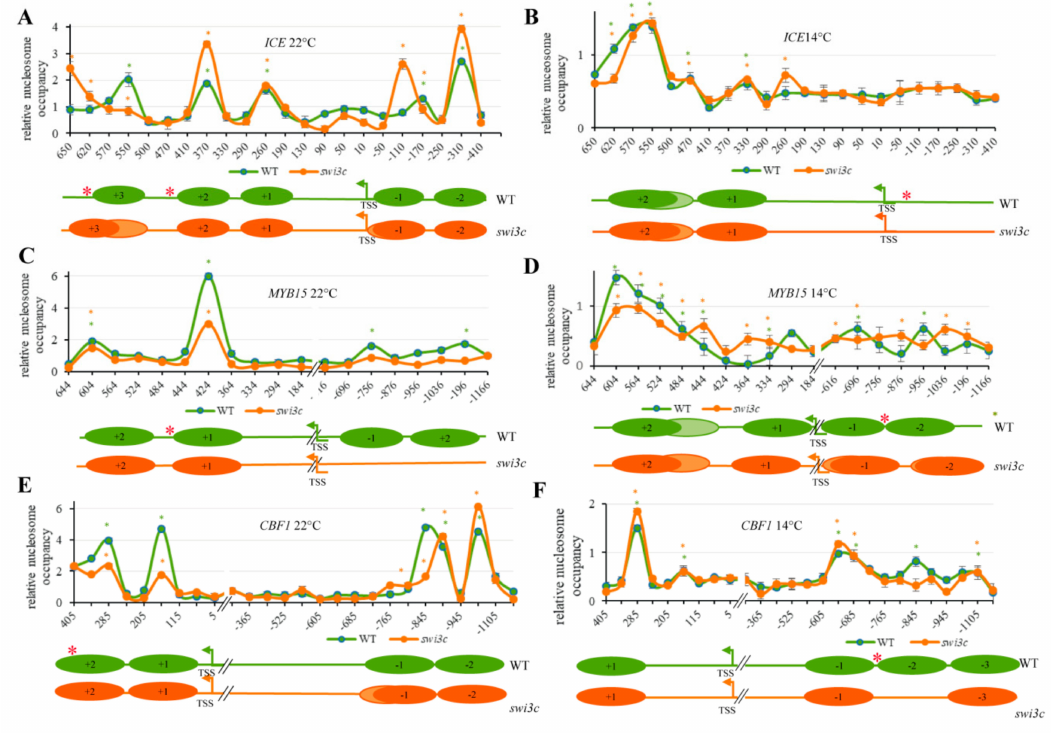
Figure 3. The E ff ect of SWI3C Inactivation on Nucleosomal Structures of ICE1 , MYB15 and CBF1 Genes. ( A ) Relative nucleosomes occupancy on the ICE1 locus in WT and swi3c plants grown at 22 ◦ C and ( B ) 14 ◦ C. ( C ) Relative nucleosome occupancy on MYB15 in WT and swi3c plants at 22 ◦ C and ( D ) 14 ◦ C. ( E ) Relative nucleosome occupancy on CBF1 in WT and swi3c plants at 22 ◦ C and ( F ) 14 ◦ C. Plants were in the principal stage with 12 rosette leaves > 1mm length according to Boyes et al. (2001) [24]. Three biological and three technical replicates were used. The fraction of undigested genomic DNA amplified for each amplicon was normalized to that of the − 73 position of GYPSY-LIKE retrotransposon (At4g07700) as control. Lower panels in each figure section show schematic illustration of nucleosome positioning and dynamics. Red asterisks indicate the localization of SWI3C protein determined by ChIP-qPCR analysis. Dark-color circles indicate positioned nucleosomes, and light colors mark non-positioned nucleosomes. Green and orange asterisks (*) indicate significant ( p < 0.05) protection of DNA from MNase digestion in WT or swi3c ,